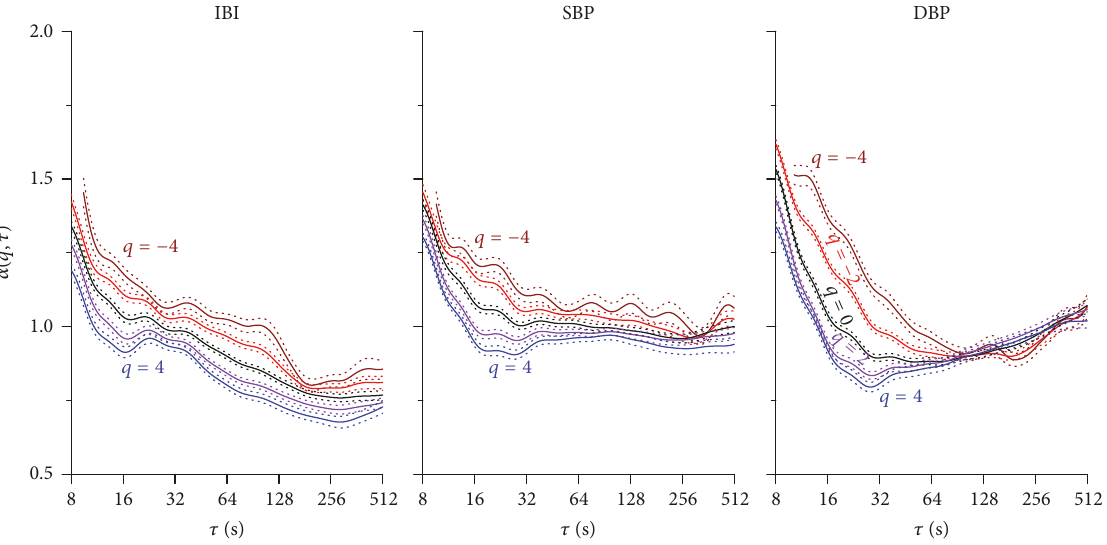
Figure 4: Multifractal and multiscale coefficients, 𝛼(𝑞, 𝜏) . Mean ± standard error of the mean over the group ( 𝑁 = 84 ) as function of 𝜏 for five q values between − 4 and +4. For clarity, the horizontal axis is plotted in a log scale.